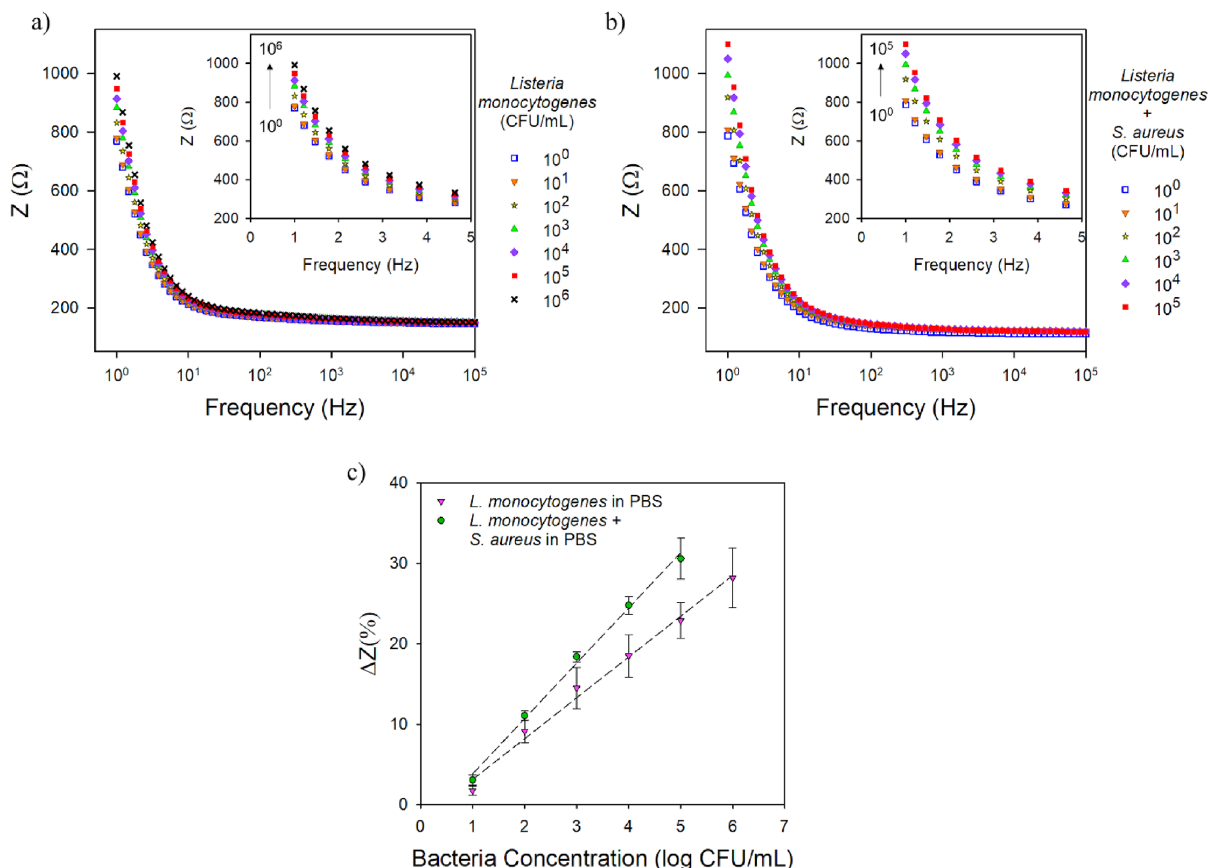
Figure 5. Representative Bode plots over the frequency range of 1–100,000 Hz (insets are a zoomed in view of the lower frequency range from 1 to 5 Hz) for the ALG-thiomer/Pt brush sensor functionalized with 400 nM aptamer exposed to ( a ) L. monocytogenes in PBS and ( b ) L. monocytogenes + S. aureus in PBS. ( c ) Calibration curves (total impedance change at 1 Hz vs. log bacteria concentration). Error bars represent the standard deviation of the arithmetic mean of at least three replicates.